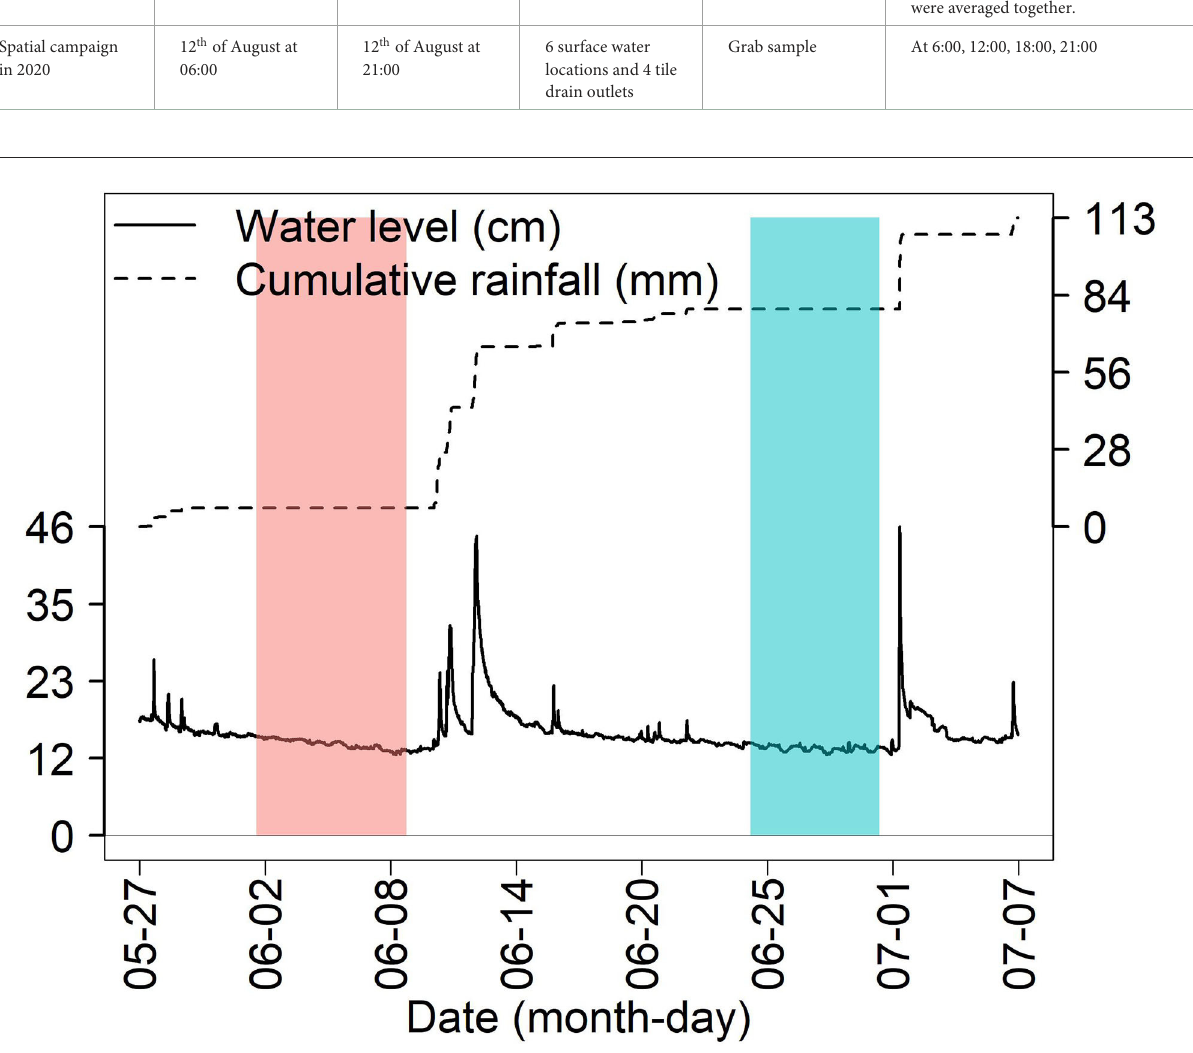
FIGURE2 Time series of water levels (solid black line) and cumulated rainfall (dashed line) showing the occurrence of the two dry periods analyzed in this research. The rectangle in salmon highlighted the first dry period and the rectangle in light blue depicted the second dry